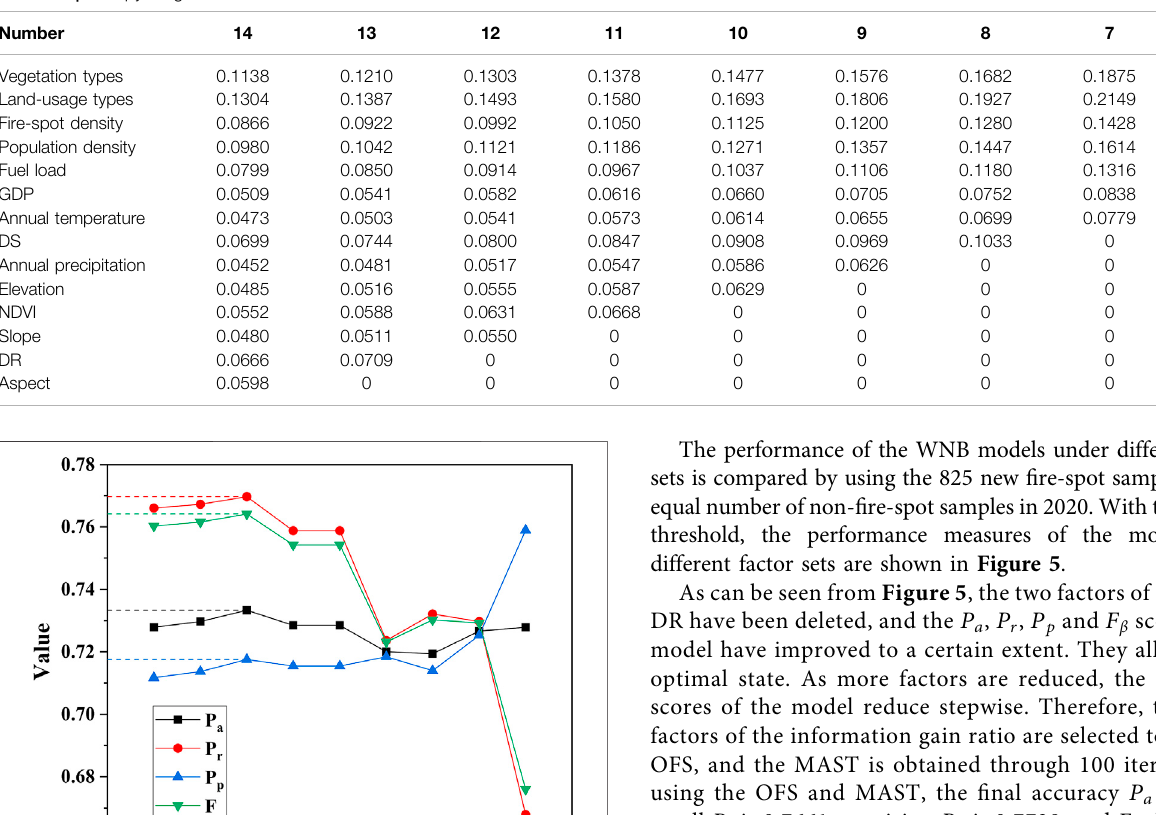
TABLE 2 | Entropy weight under different factors.